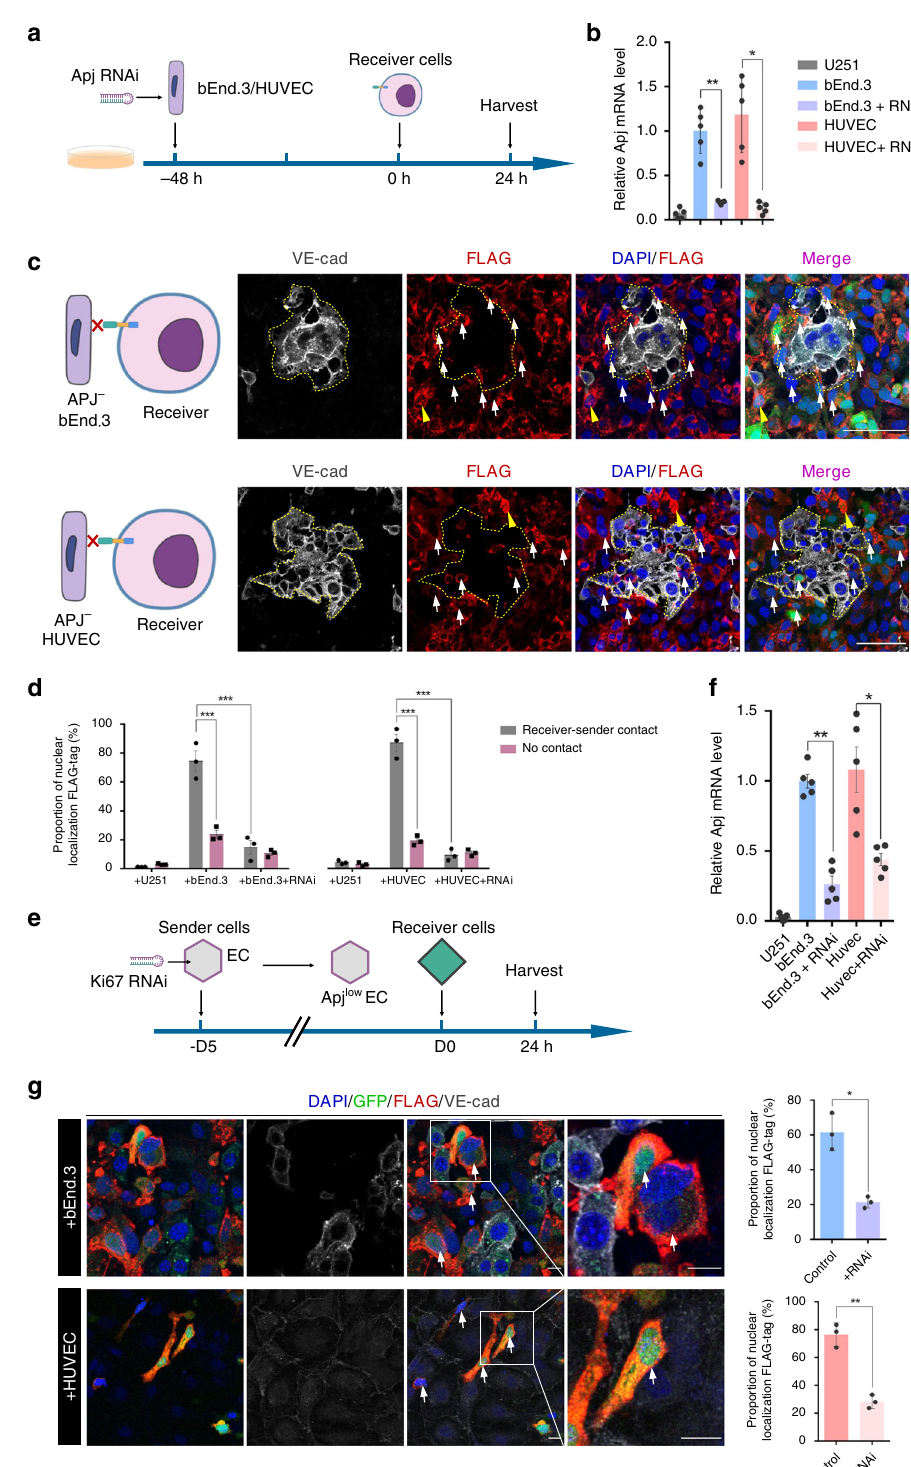
and ∼ 58% of the engineered cells turned red within 24 hours (Supplementary Fig. 9a, b). The whole-mount fl uorescence ima- ges showed that the engineered cells turned red in tumors (Fig. 5b), but there were quite few engineered cells with RFP reporters activated in the normal tissues (Fig. 5b), including in the heart, lungs, liver and spleen, corresponding with the Apj dis- tribution in adults 7,8,32 . These data indicate that engineered cells with AsNRs could sense the endothelial cells of sprouting